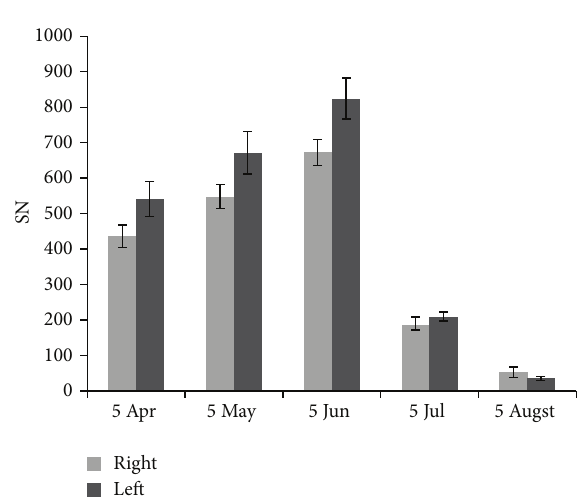
Figure3:Meanofspermnumber(SN)of Phrynocephalusmaculatus from April to August.